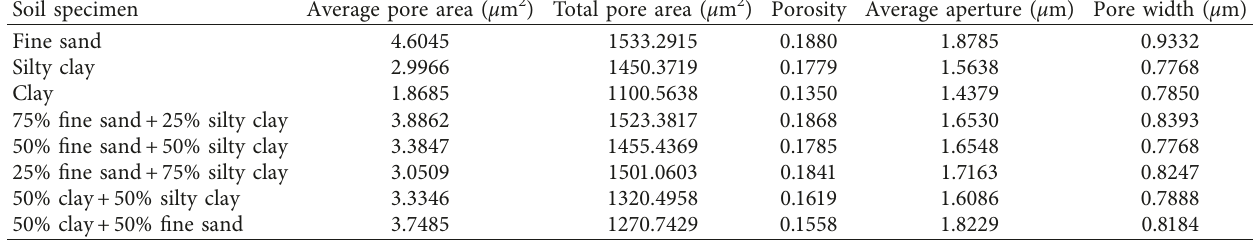
Table 10: Image analysis results of microstructure parameters.